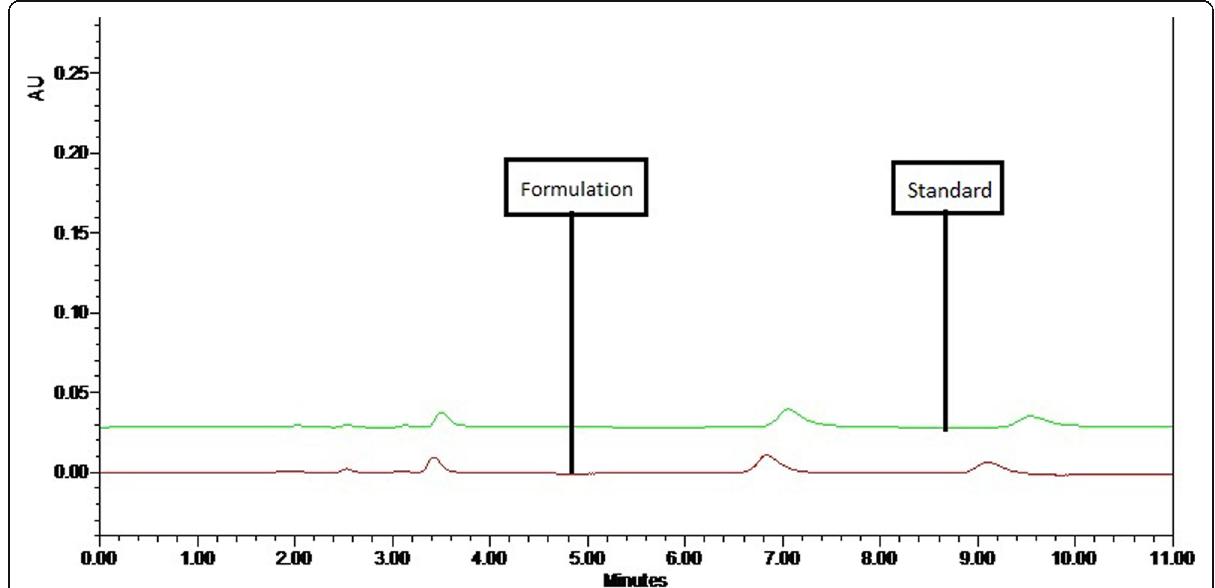
Fig. 5 Overlay chromatogram comparison of active pharmaceutical ingredient and marketed